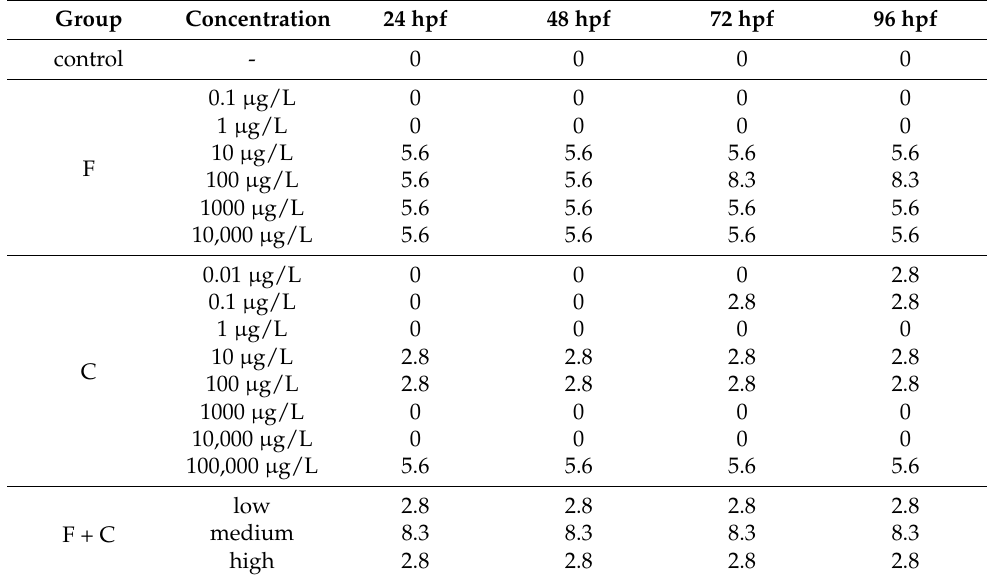
Table 1. Cumulative mortality (%) of zebrafish embryos exposed to antidepressants as single sub- stances and as a mixture. No significant differences ( p > 0.05) were observed between the control and the experimental groups at the same time of exposure.